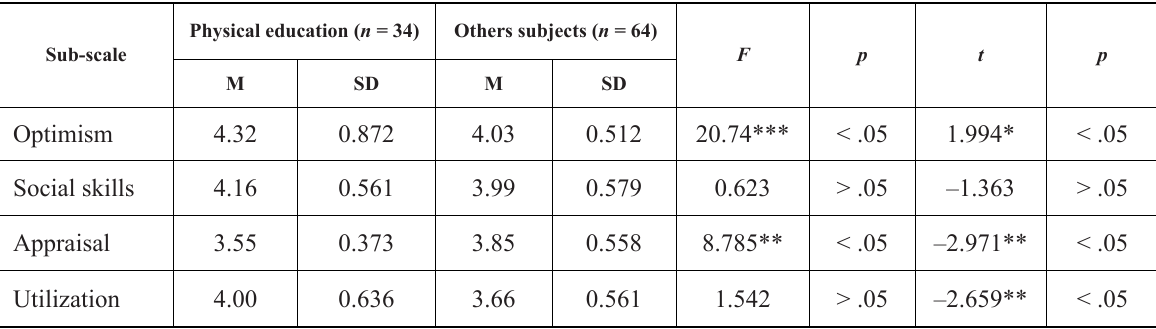
Table 3. Teacher self-report of emotional abilities estimation subject taught (scores)